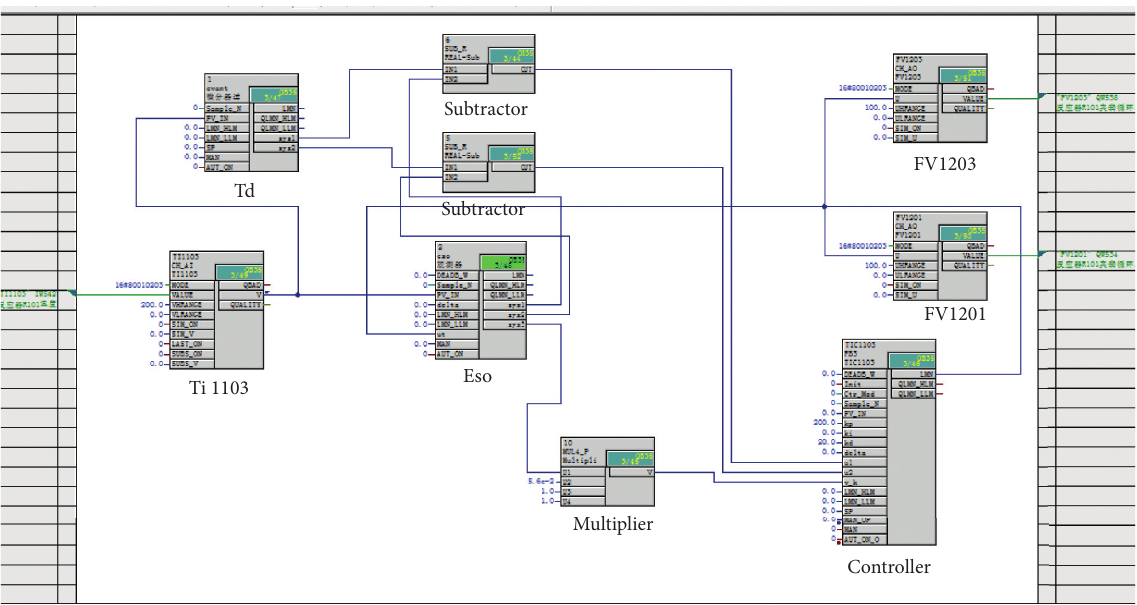
Figure 5: Improved autodisturbance rejection principle CFC diagram.